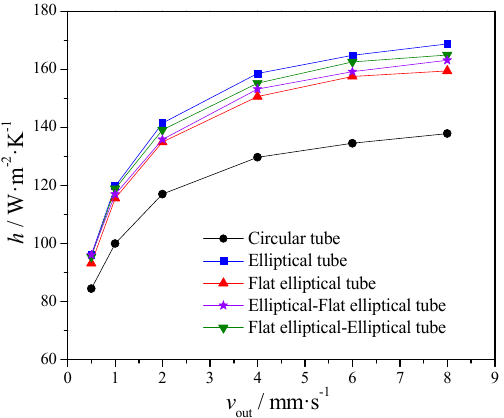
Figure 9. Variations of local heat transfer coefficients of particle flow with v out for different tubes ( d p = 1.72 mm): ( a ) Zone 1; ( b ) Zone 2 and Zone 3.